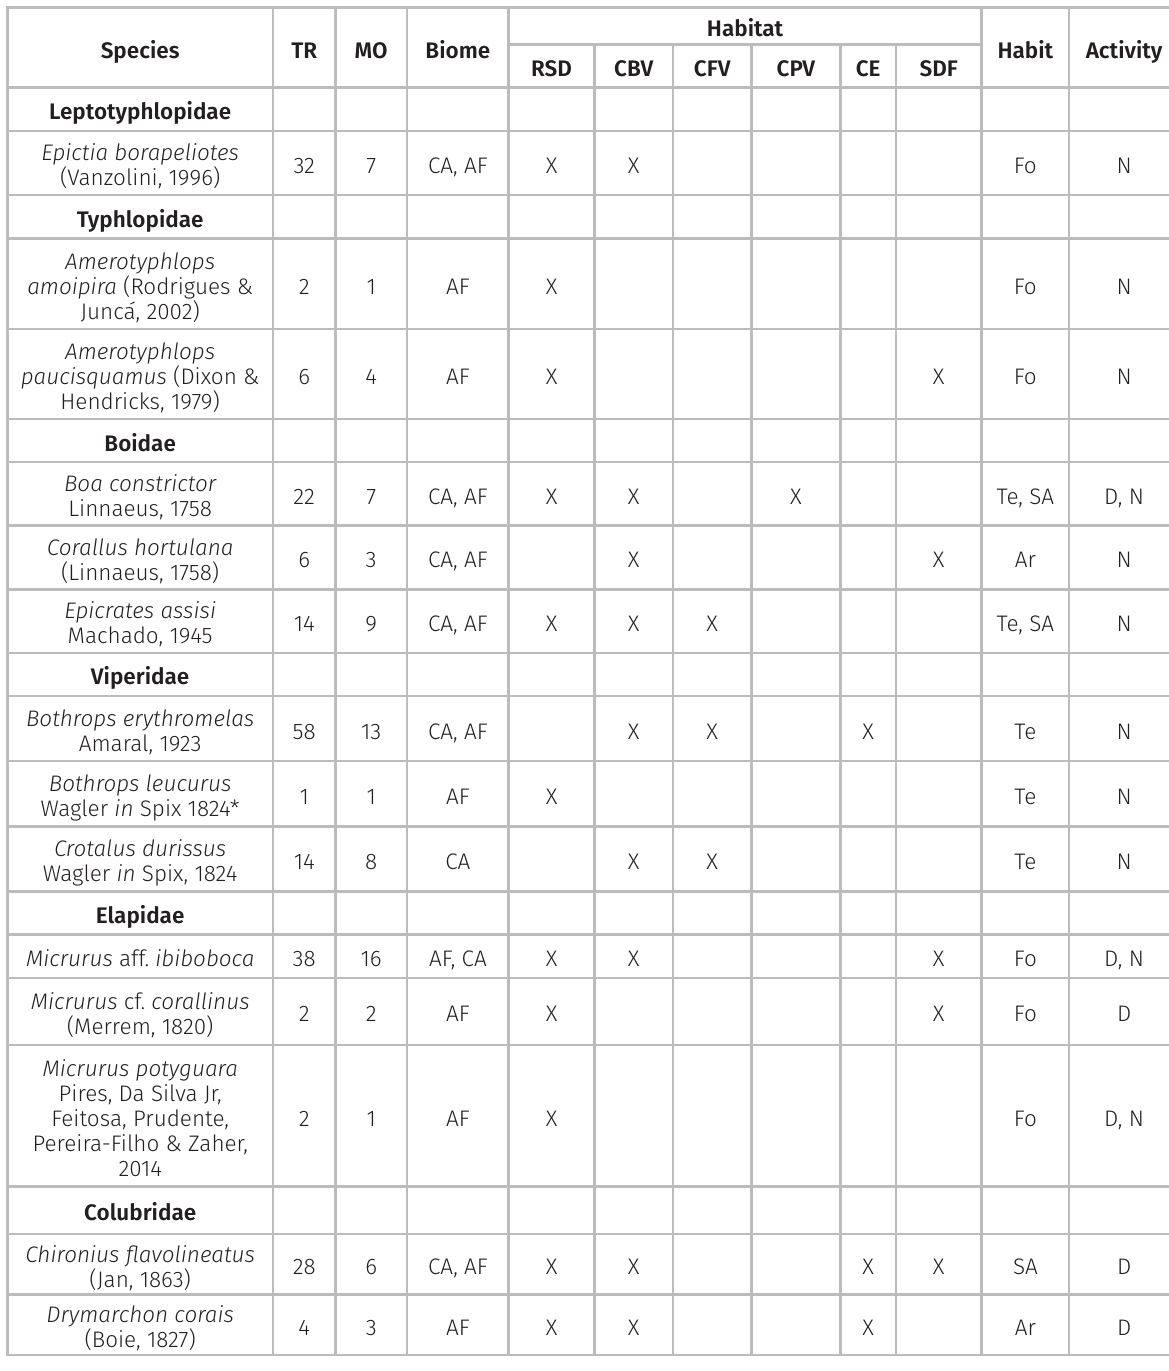
Table I. Snake species recorded in Rio Grande do Norte state, Brazil. The table outlines total records for each species (TR), total municipalities of occurrence (MO), biomes (Caatinga – CA and/or Atlantic Forest – AF), habitats (restinga sand dunes – RSD, caatinga bush vegetation – CBV, caatinga forest vegetation – CFV, caatinga parkland vegetation – CPV, cerrado – CE, and semideciduous forest – SDF. Snakes habits are as follows: aquatic (Aq), arboreal (Ar), fossorial (Fo), terrestrial (Te) and semiarboreal (SA). Activity period: diurnal (D) and nocturnal (N). (*) New state